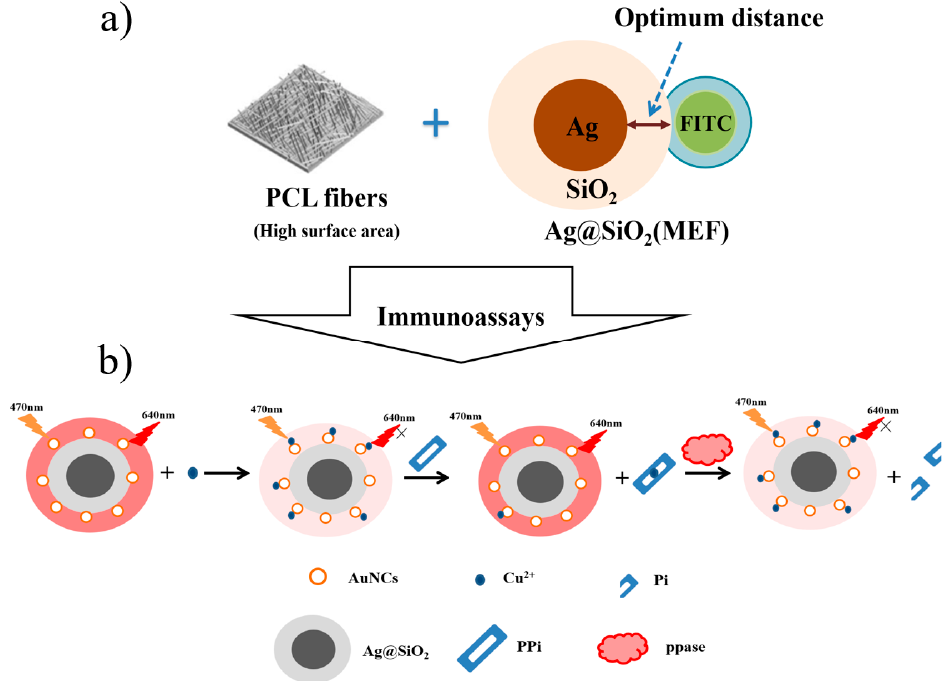
Figure 34. ( a ) Schematic illustration of MEF-based Ag@SiO 2 platform. Adapted from Ref. [129]. ( b ) Schematic drawing of AuNCs conjugated to the surface of the Ag@SiO 2 core–shell hybrid nano-system. Adapted from Ref. [130].